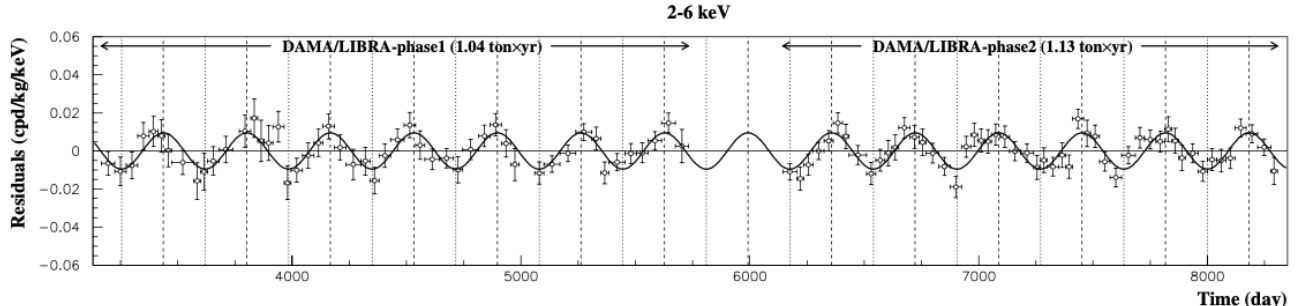
Figure 1. Experimental residual rate of the single-hit scintillation events measured by DAMA/LIBRA–phase1 and DAMA/LIBRA–phase2 in the (2–6) keV energy interval as a function of the time. The superimposed curve is the cos- inusoidal functional forms A cos ω ( t i − t 0 ) with a period T = 2 π / ω = 1 year, a phase t 0 = 152.5 day (2 June) and modulation amplitudes, A , equal to the central values obtained by best fit on the data points of DAMA/LIBRA–phase1 and DAMA/LIBRA–phase2. The dashed vertical lines correspond to the maximum expected for the dark matter signal (2 June), while the dotted vertical lines correspond to the minimum. Reprinted from Ref. [41] under Copyright Permission of the Institute for Nuclear Research of the National Academy of Sciences of